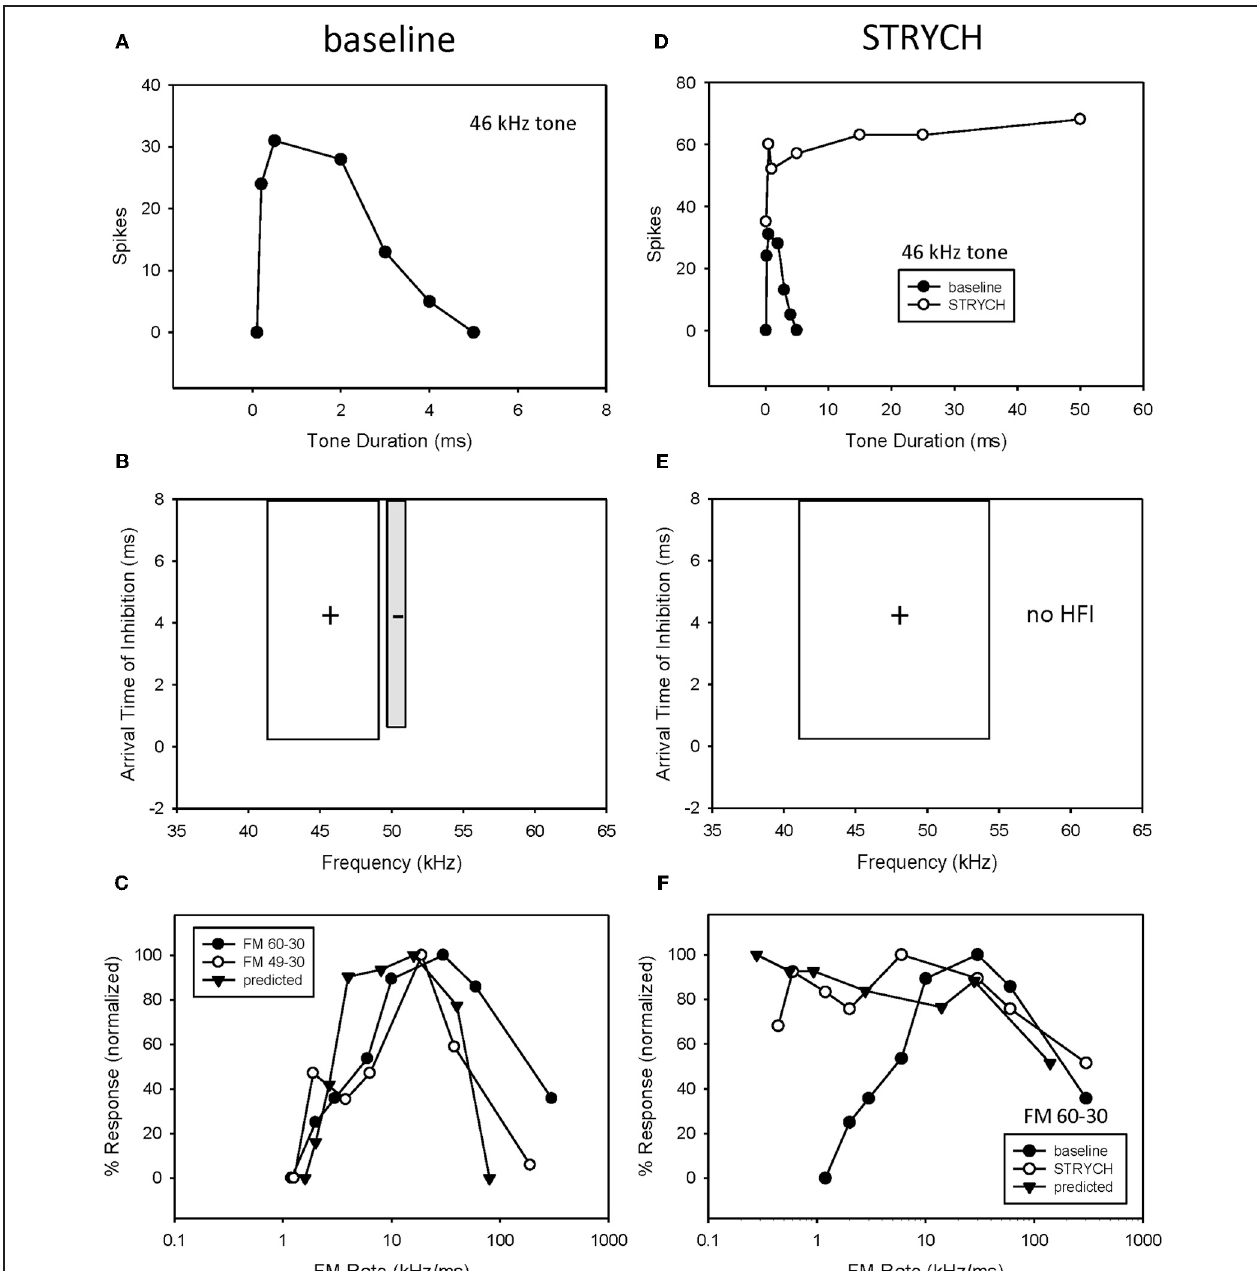
FIGURE 8 | If more than one mechanism was present both had to be eliminated before FM rate selectivity was affected. In this neuron, exhibiting both bandpass duration tuning (A) and HFI (B) , the elimination of